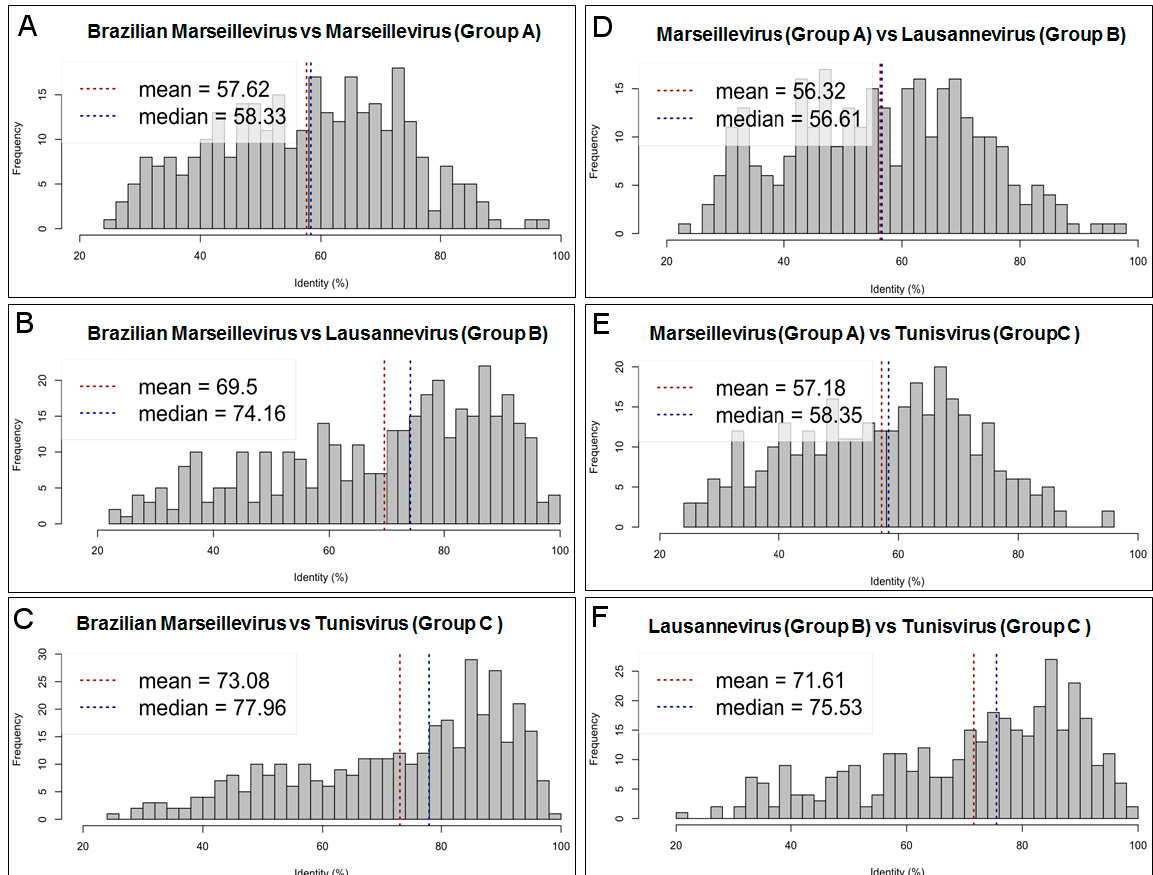
Figure 3. Average amino acid identity. In this analysis, estimates were reached using both best hits (one-way AAI) and reciprocal best hits (two-way AAI) between two datasets of proteins from the BrMV isolate and representative strains from marseillevirus groups ( A – C ). Plots ( A – C ) demonstrate the amino acid comparison between BrMV and marseilleviruses from groups ( A – C ); Plots ( D – F) compare marseilleviruses from different lineages.